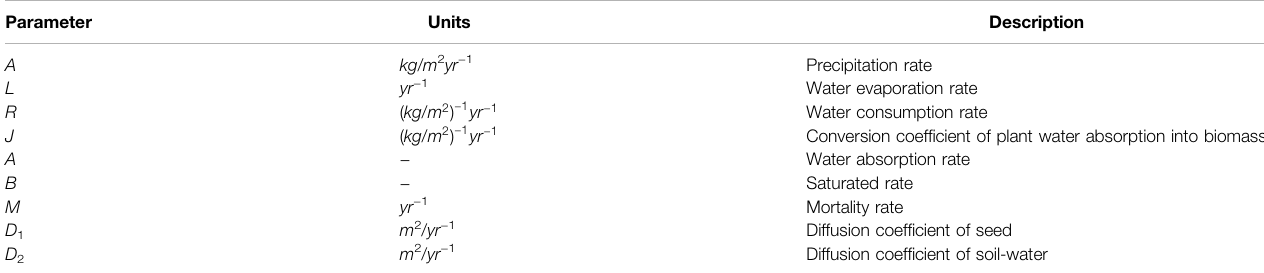
TABLE 1 | Description of the parameters in the model (2).